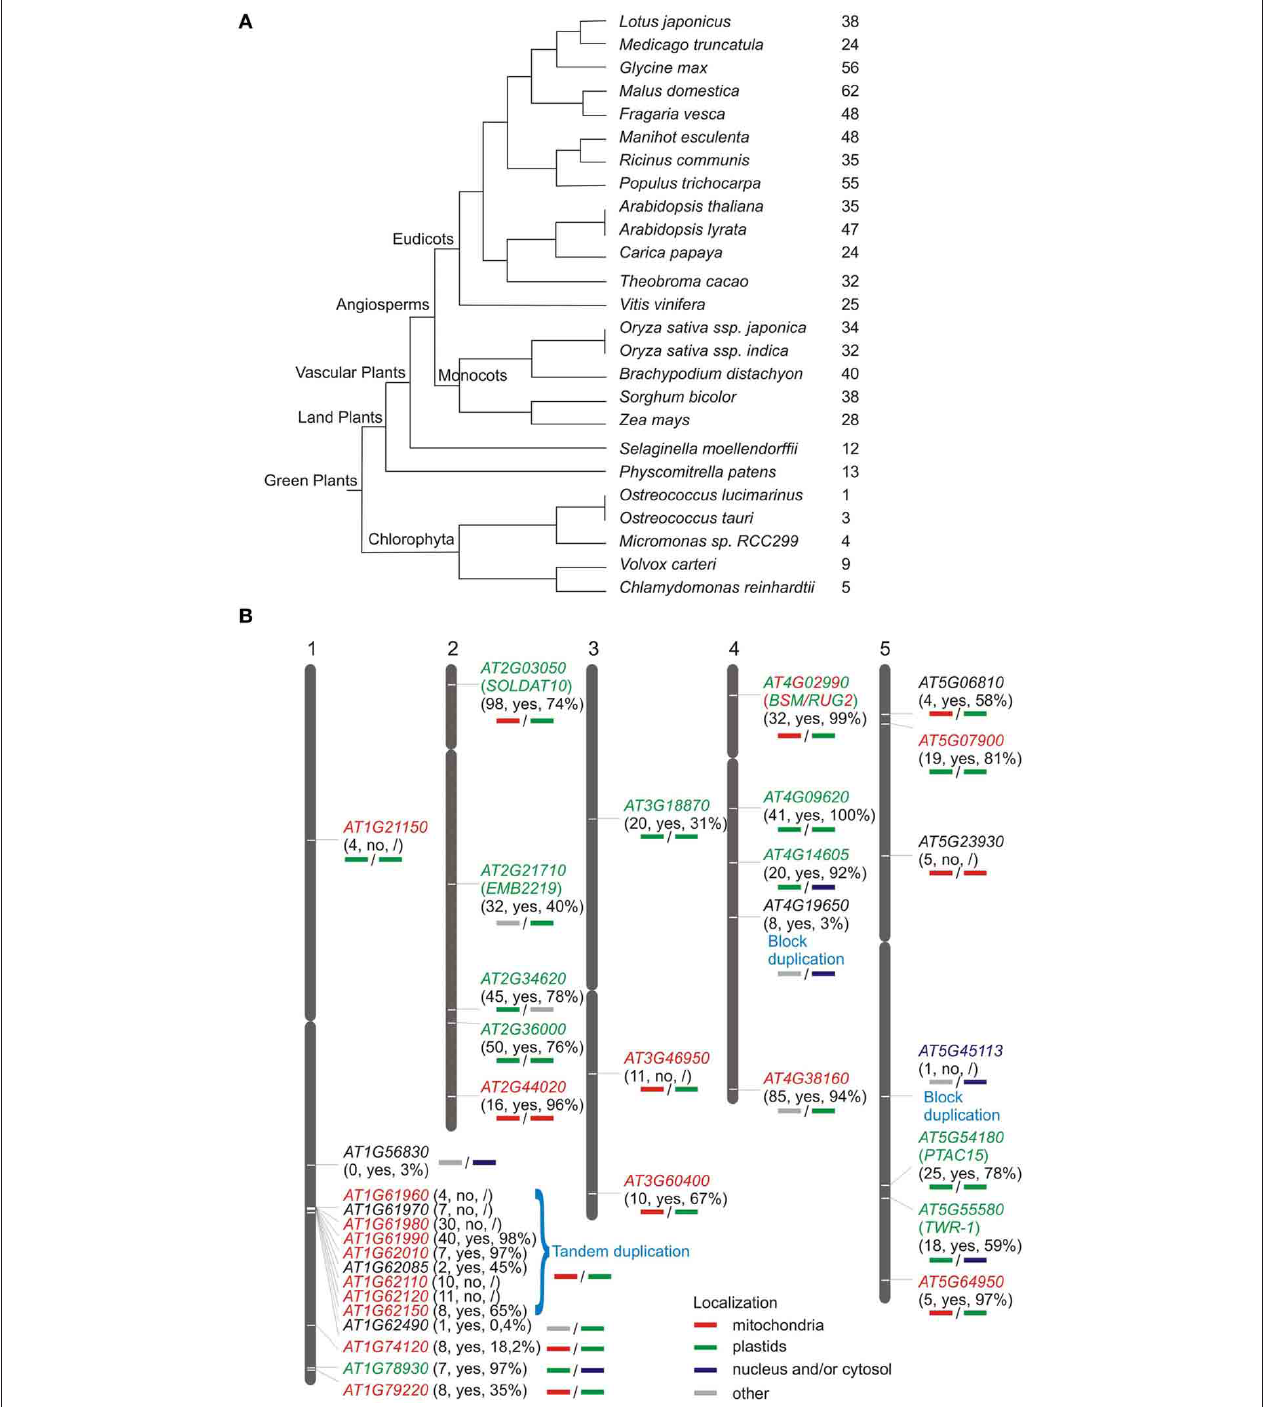
FIGURE 1 | Distribution of genes encoding mTERF proteins in plants. (A) Numbers of MTERF genes in sequenced green plants according to the PLAZA database (http://bioinformatics.psb.ugent.be/plaza/). (B) Chromosomal distribution of A. thaliana MTERF genes. Approximate positions of MTERF genes are displayed on the respective chromosome. The first numbers in parentheses report the EST support values; “yes” or “no” indicates whether or not the respective MTERF is represented on Affymetrix ATH1 arrays; the percentage value indicates the fraction of all microarray datasets deposited in